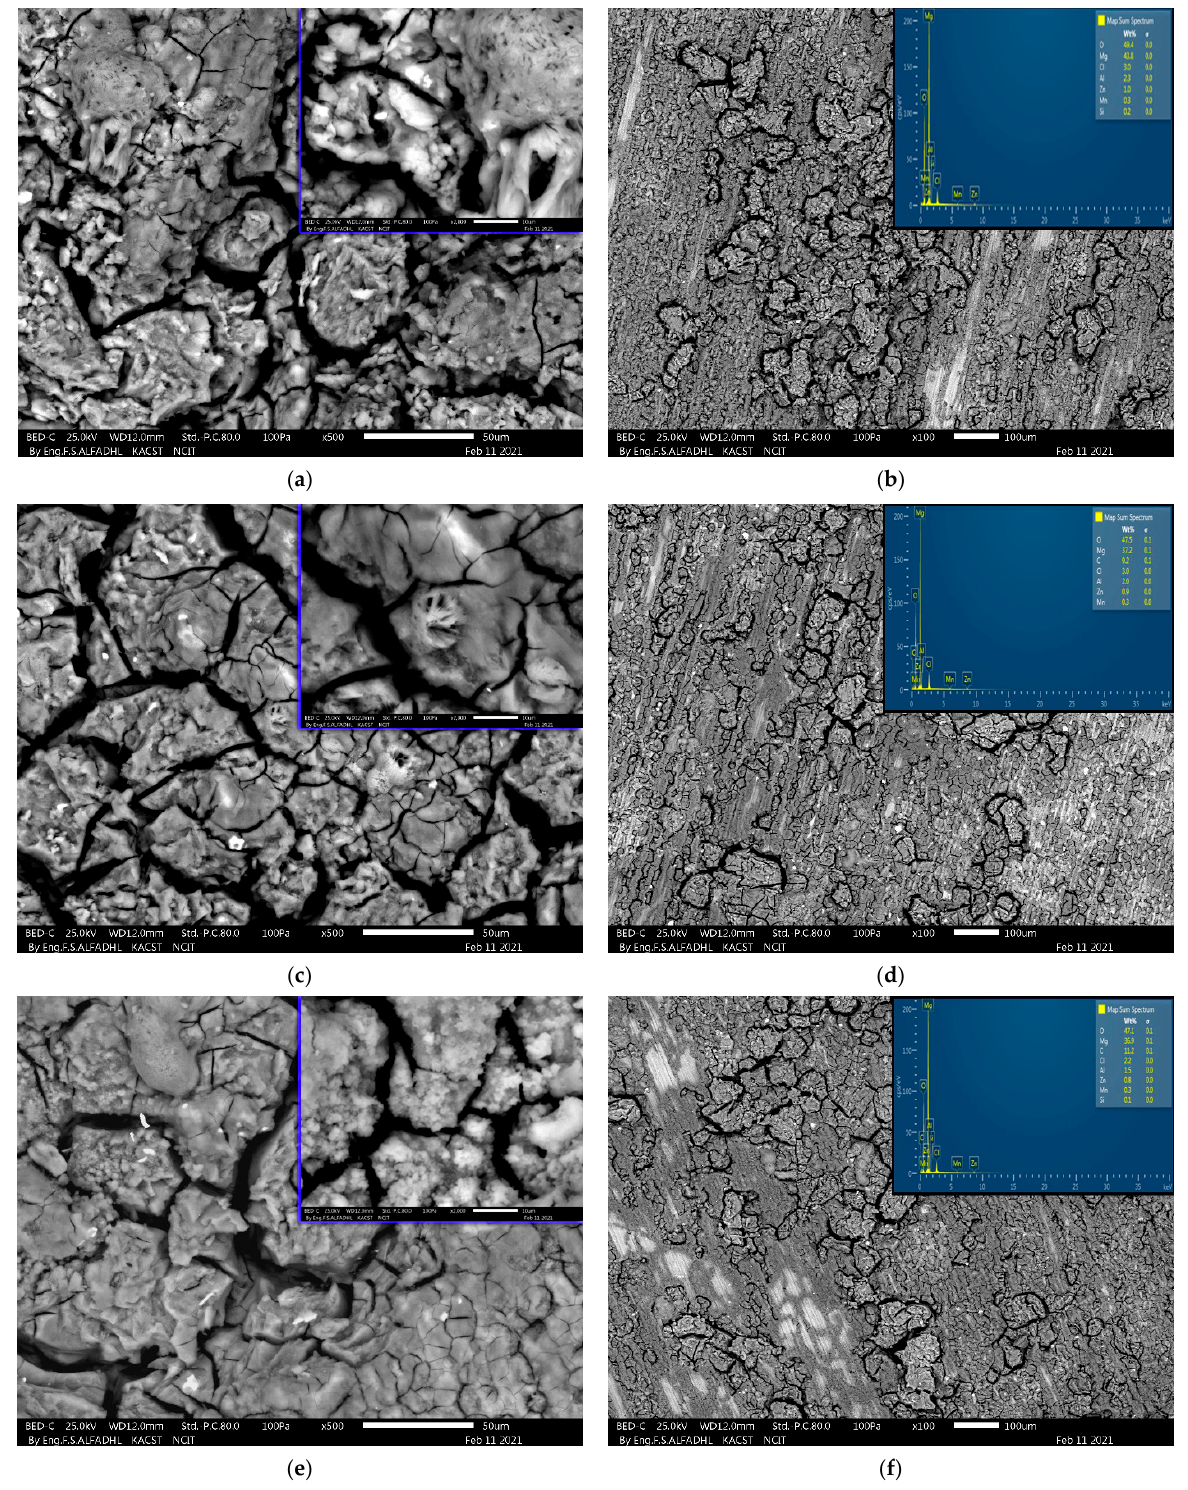
Figure 6. SEM micrographs of the AZ31 alloy after corrosion test ( a , b ) AA, ( c , d ) 1-P, and ( e , f ) 2-Bc at ( a , c , e ) high magnification Figure 6 . SEM micrographs of the AZ31 alloy after corrosion test ( a,b ) AA, ( c,d ) 1-P, and ( e,f ) and ( b , d , f ) low magnification coupled with the EDS 2-Bc at ( a,c,e ) high magnification and ( b,d,f ) low magnification coupled with the EDS spec- trum .